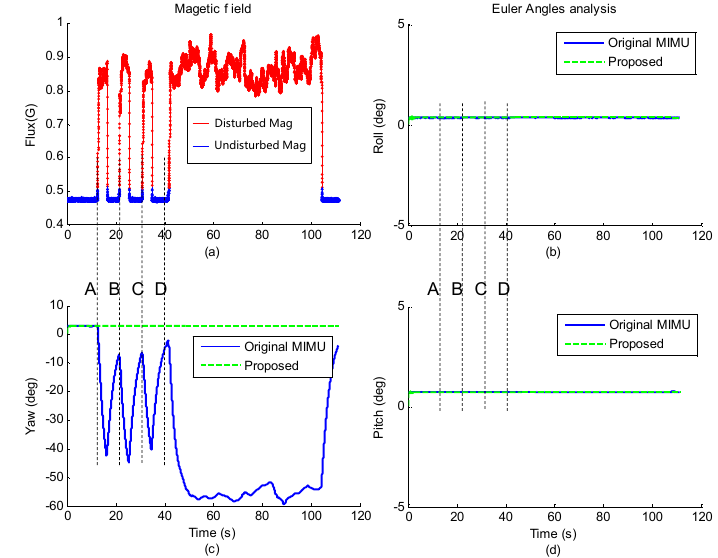
Figure 8. Comparison of Euler angles estimated by different fusion algorithms under stationary state. ( a ) Three-axis magnetic field measured by the magnetometer; The roll ( b ), pitch ( c ) and yaw ( d ) angle estimated by original MIMU gradient descent algorithm and the proposed method.